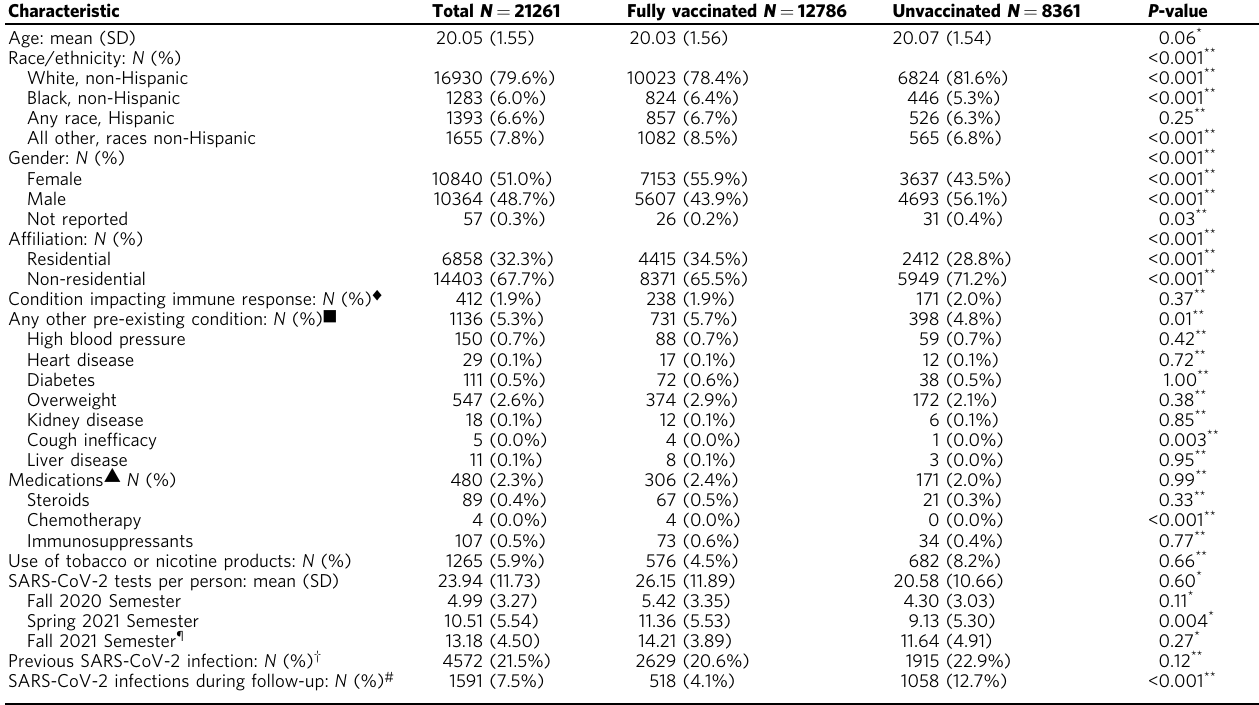
Table 1 Descriptive characteristics for study sample.